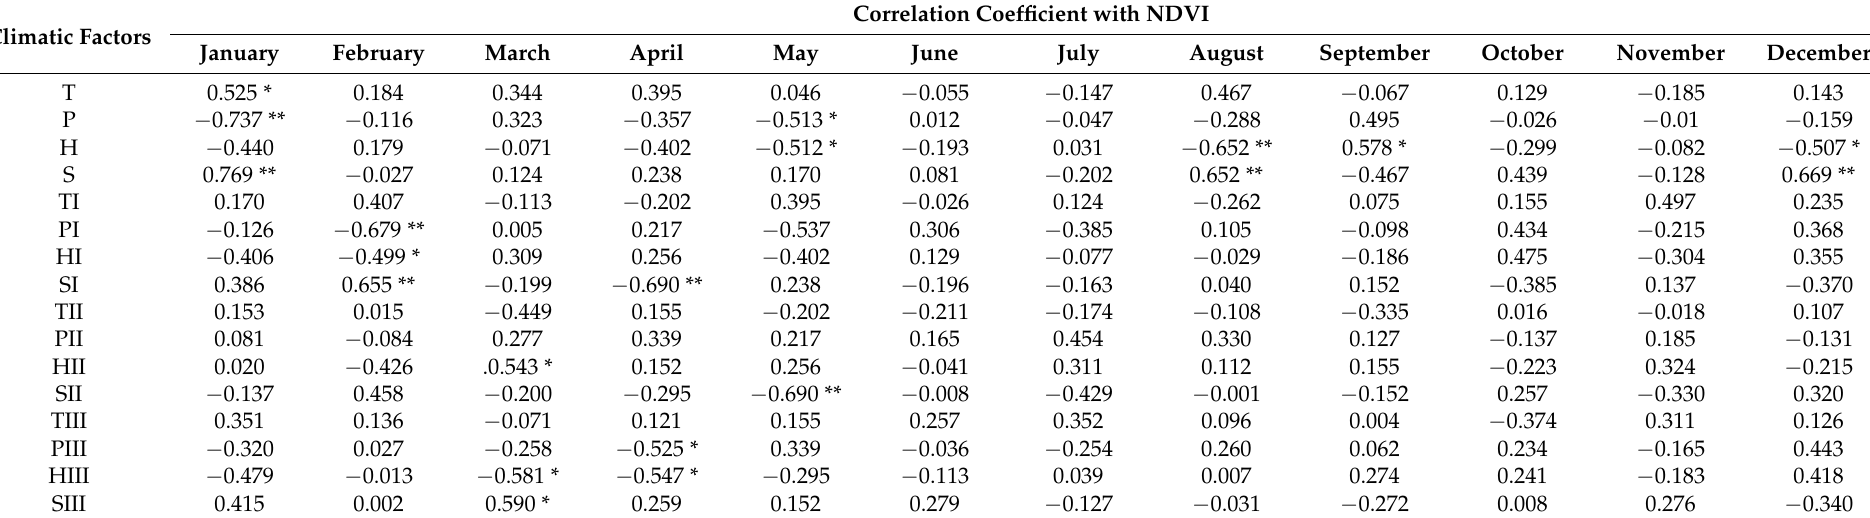
Table 7. Pearson correlation coefficients between natural forests vegetation NDVI in each month and climatic factors in current and previous one, two, and three months, respectively.